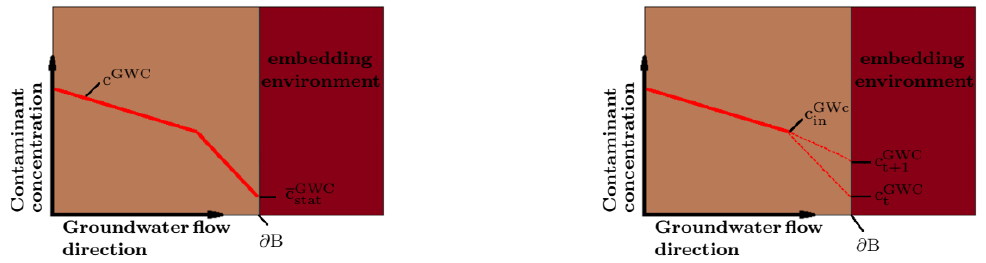
Figure 2. Depiction of stabilized contaminant concentration gradient at the